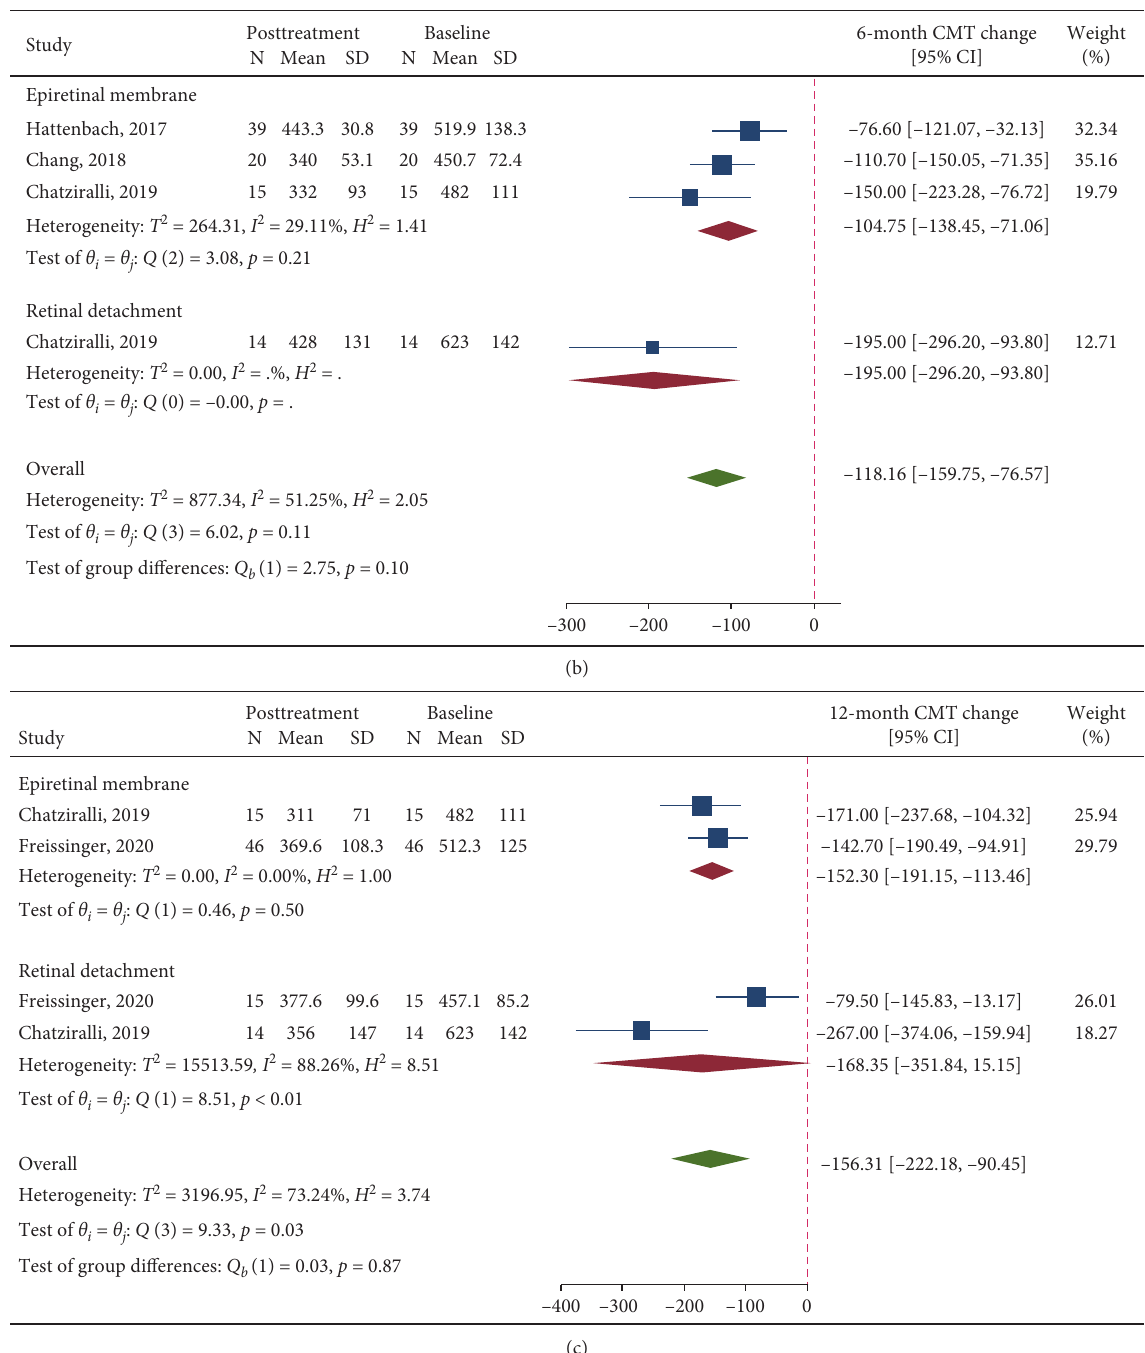
Figure 5: A forest plot showing mean change in central macular thickness at 1-month (a), 6-month (b), and 12-month (c) follow-up after treatment with dexamethasone